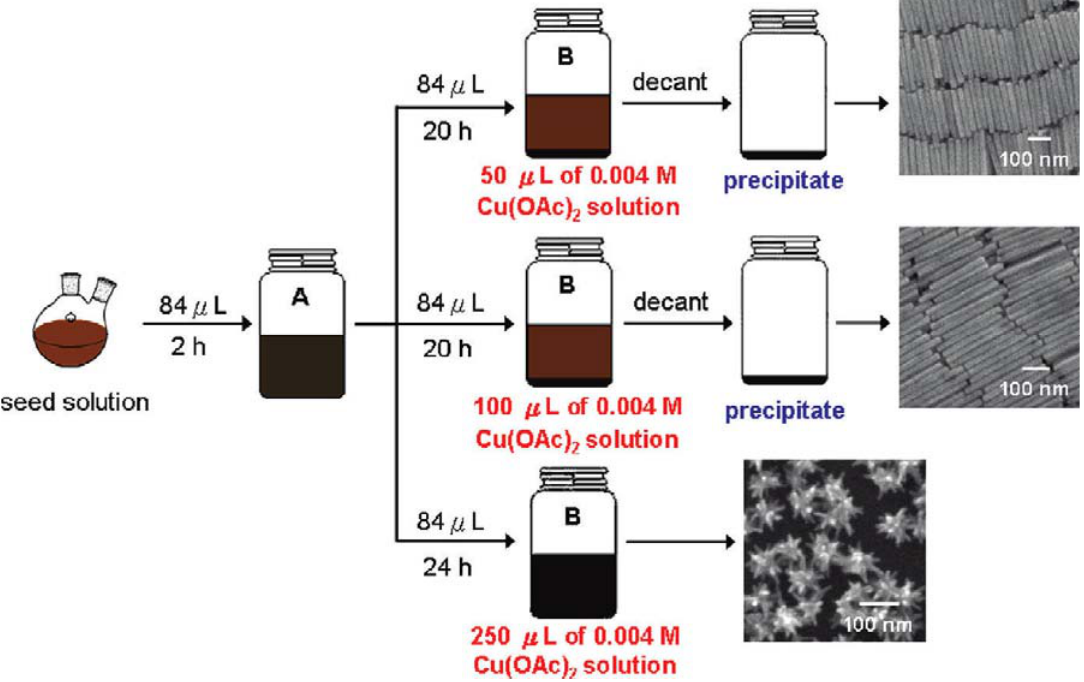
Figure 2. Schematic of the seed-mediated growth process for synthesis of palladium nanorods and branched palladium nanostructures Reprinted (“adapted” or “in part”) with permission from [40]. © 2009 American Chemical